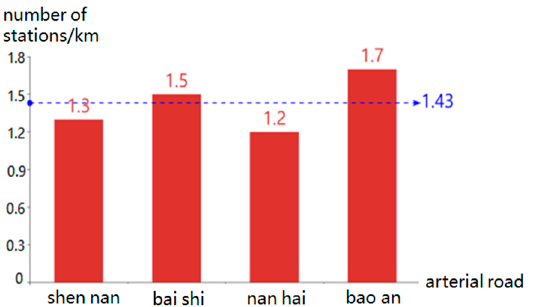
Figure 2. Number of bus stops per kilometer included in arterial roads.